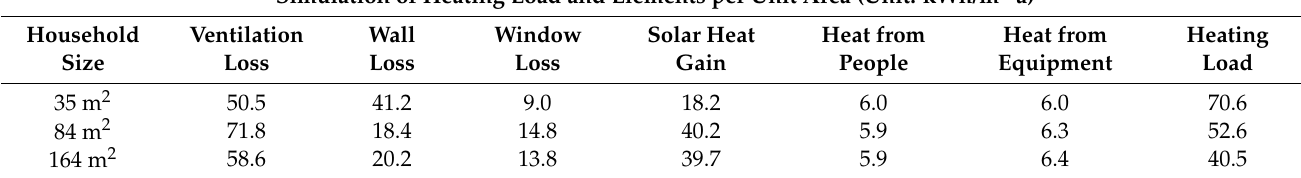
Table 8. Annual heating load per unit area according to the growth in house size